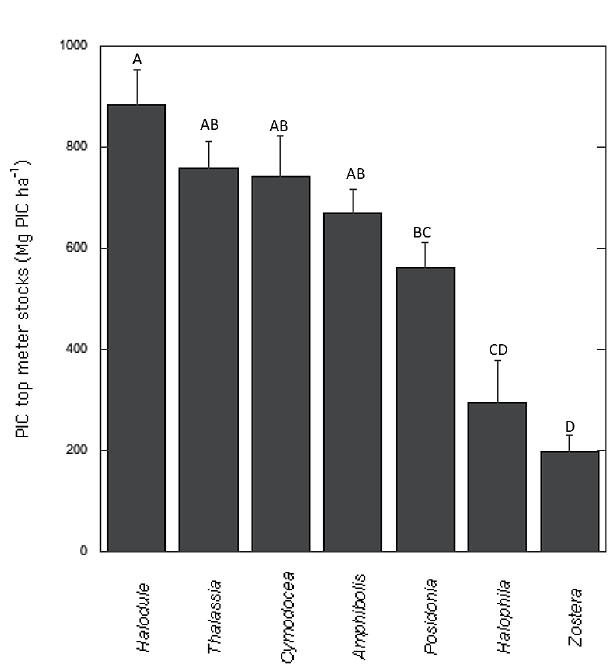
Figure 3. Average PIC stocks (MgPICha − 1 ) ± SE across the dom- inant seagrass genera forming the meadows. Only genera with more than 10 observations are shown. Identical letters indicate no signif- icant differences between dominant species forming the meadows (ANOVA and post hoc Tukey